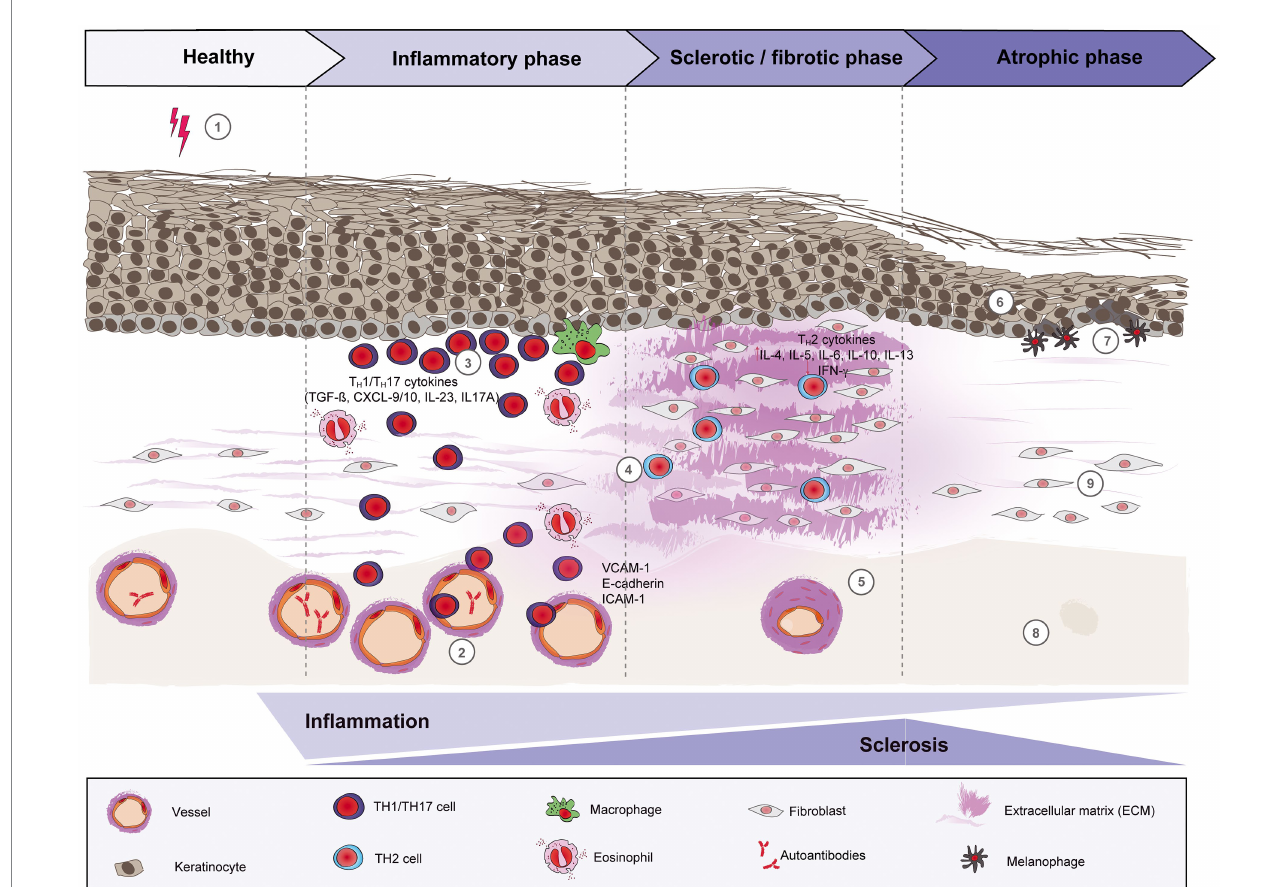
FIGURE 1 Schematic overview of morphea pathogenesis. Based on current evidence, the pathogenesis of morphea can be divided into three distinct phases: early inflammatory, sclerotic/fibrotic and late atrophic. Environmental factors like radiation, skin trauma and infections may trigger in genetically predisposed patients (1) a T cell-driven skin inflammation, but also plasma cells and eosinophils around the vessels, adnexal structures and in the dermis. The resulted intense endothelial damage will lead to the upregulation of adhesion molecules, such as E-cadherin and VCAM-1 during the inflammatory stage (2), which in turn will recruit pro-inflammatory TH1 and TH17 cells and associated cytokines (CXCL-9/10, TGF-ß, IL-23 and IL-17A, respectively) that will activate fibroblasts. (3) Next, a switch towards a predominant TH2-driven response will facilitate the recruitment of T lymphocytes that are capable of producing profibrotic cytokines like IL-4, IL-6 and TGF-ß. (4) Therefore, sclerosis increases with hyalinized, compact collagen bundles in the dermis, with few sweat glands and blood vessels, the latter with thickened walls and narrow lumens. (5) In the last phase, atrophy slowly increases as sclerosis subsides. The epidermis will decrease in thickness (6), while basal keratinocytes display pigment, with the presence of underlying melanophages. (7) There is loss of skin appendages, blood vessels (8) and inflammatory cells